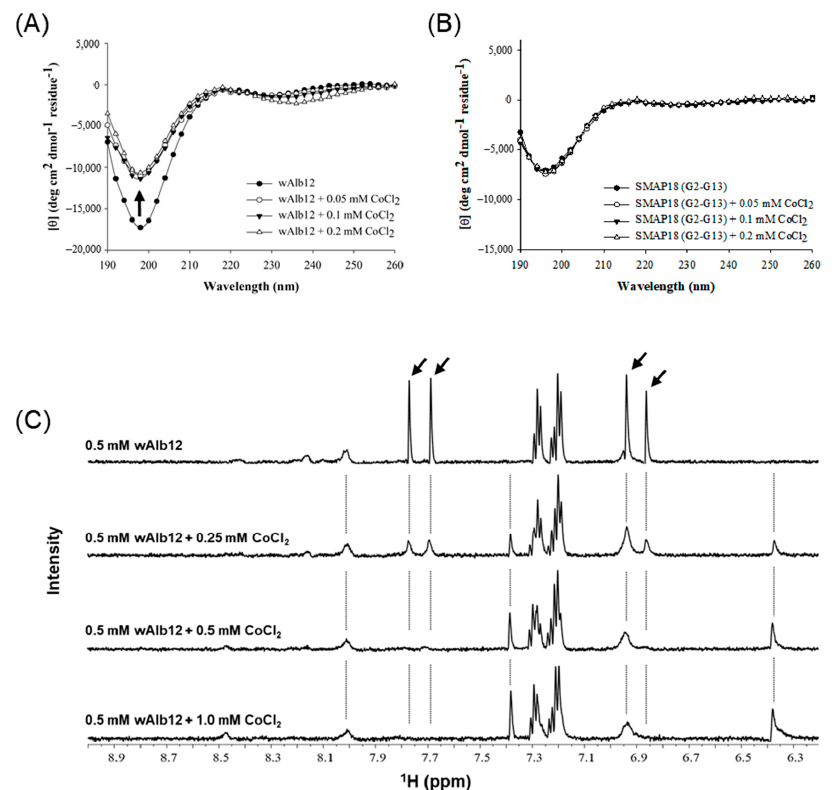
Figure 4. The CD and NMR spectral changes of peptides by Co(II) binding. The CD spectra of wAlb12 ( A ) and SMAP18 (G2-G13) ( B ). ( C ) 1D proton NMR spectral changes of the wAlb12 by adding of CoCl 2 . Arrows indicates that the peaks were largely broadened out by adding of CoCl 2 .